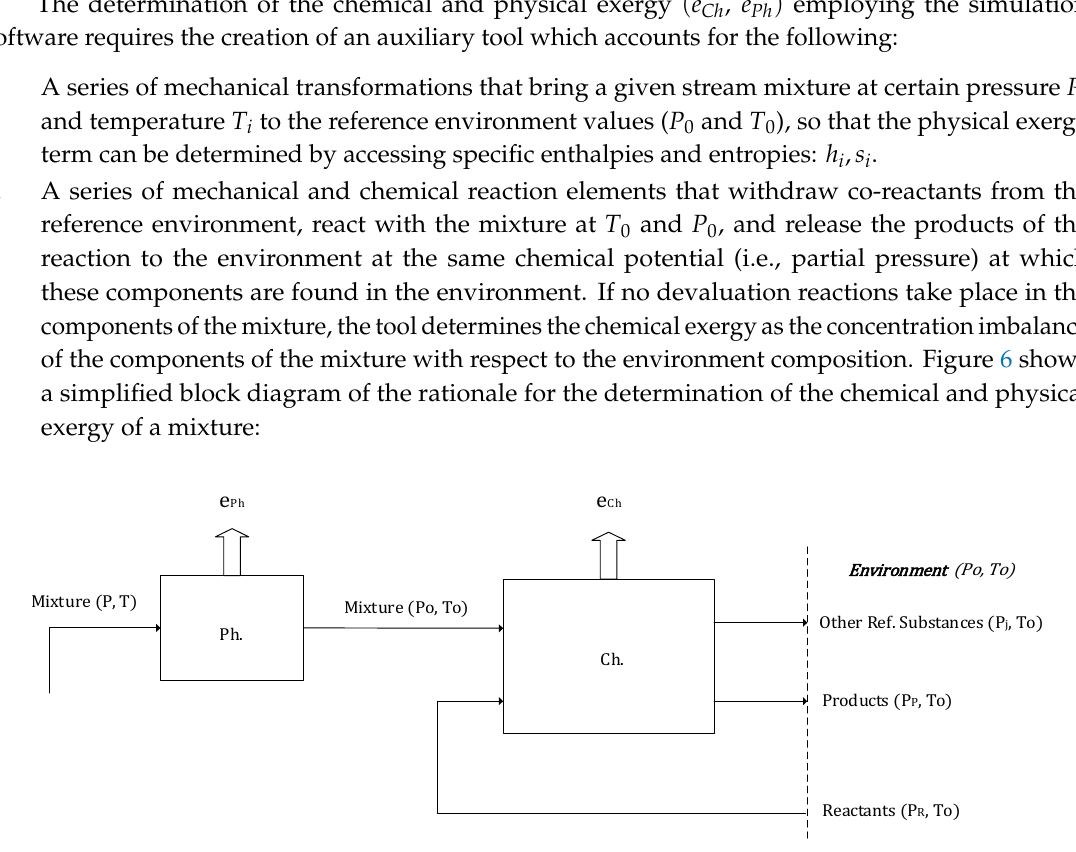
Figure 6. Schematic of the modeling tool employed to determine the chemical exergy of a stream.